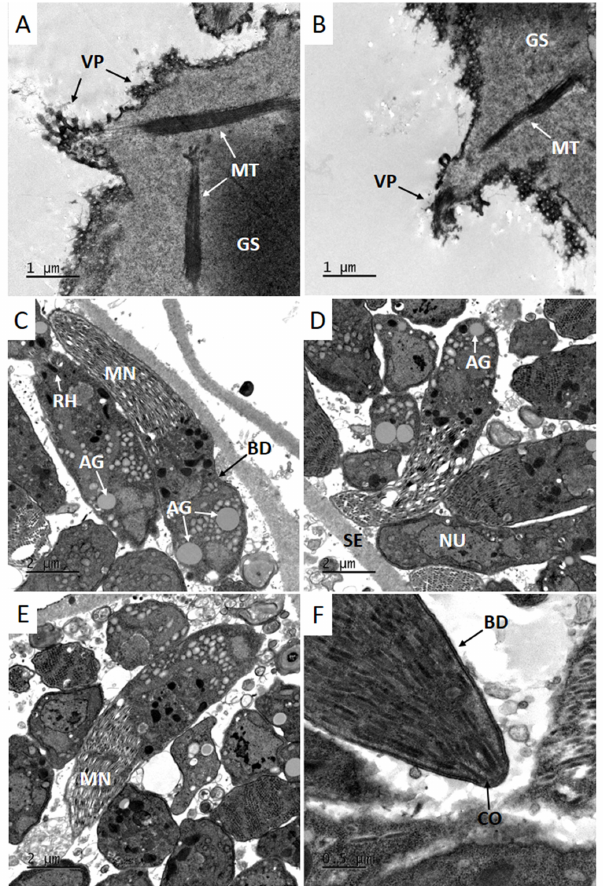
Figure 2. Sarcocystis bertrami from Brazilian horses observed using transmission electron microscopy of tongue tissues. ( A , B ) Villar protrusions (VP) on cyst walls and microtubules (MT) along the villi